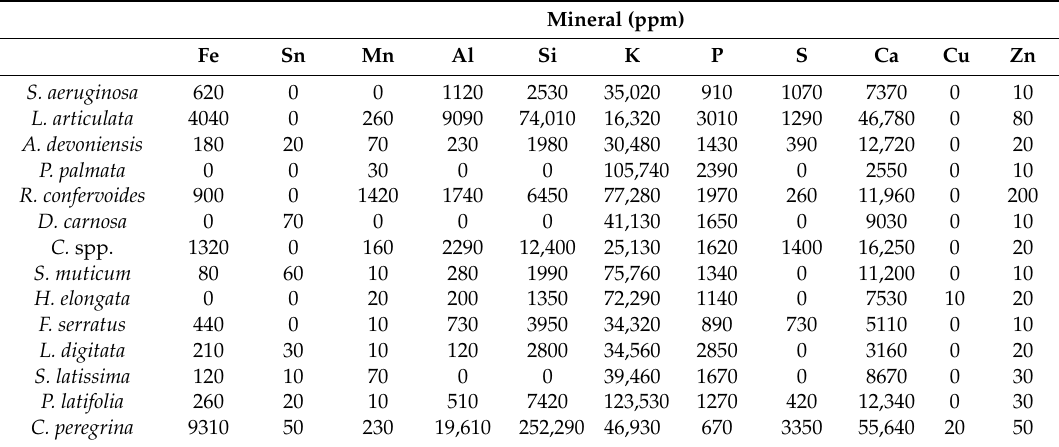
Table 5. Mineral composition of seaweeds from South West England (ppm). One ppm is equivalent to 0.0001% of total dry